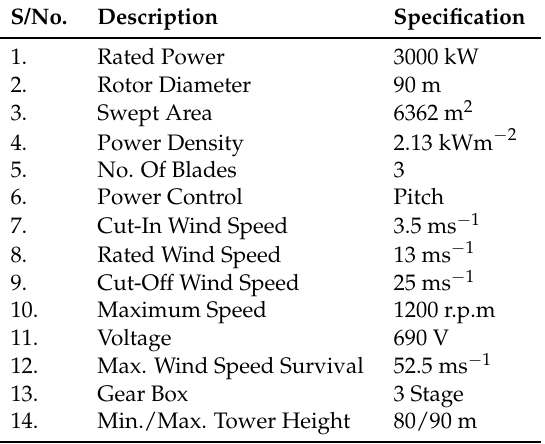
Table 1. Wind turbine